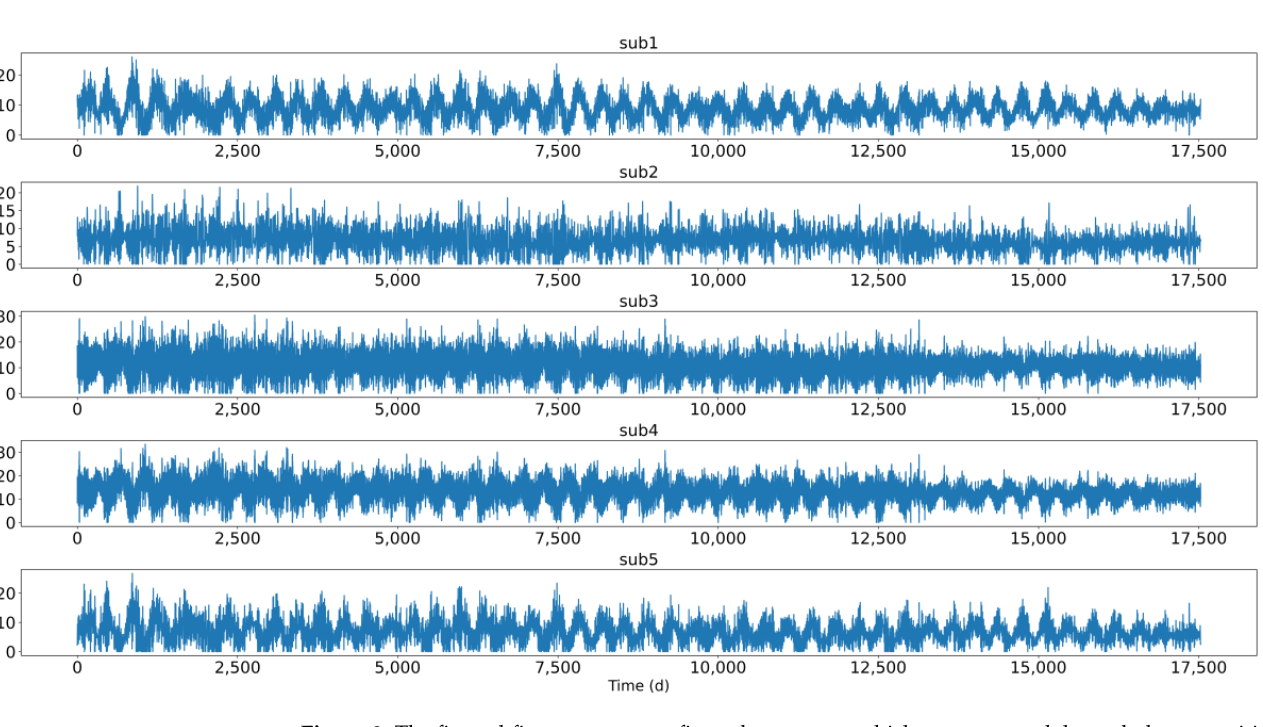
and dimension reduction from the original time series in case 2.